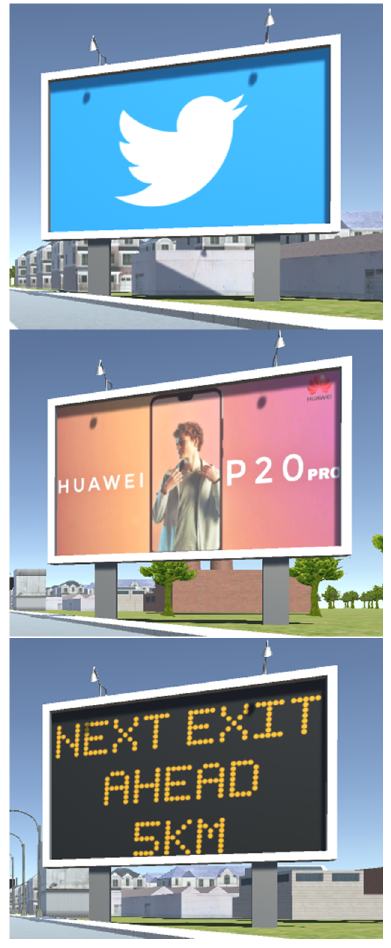
Figure 4. Examples of digital billboard.